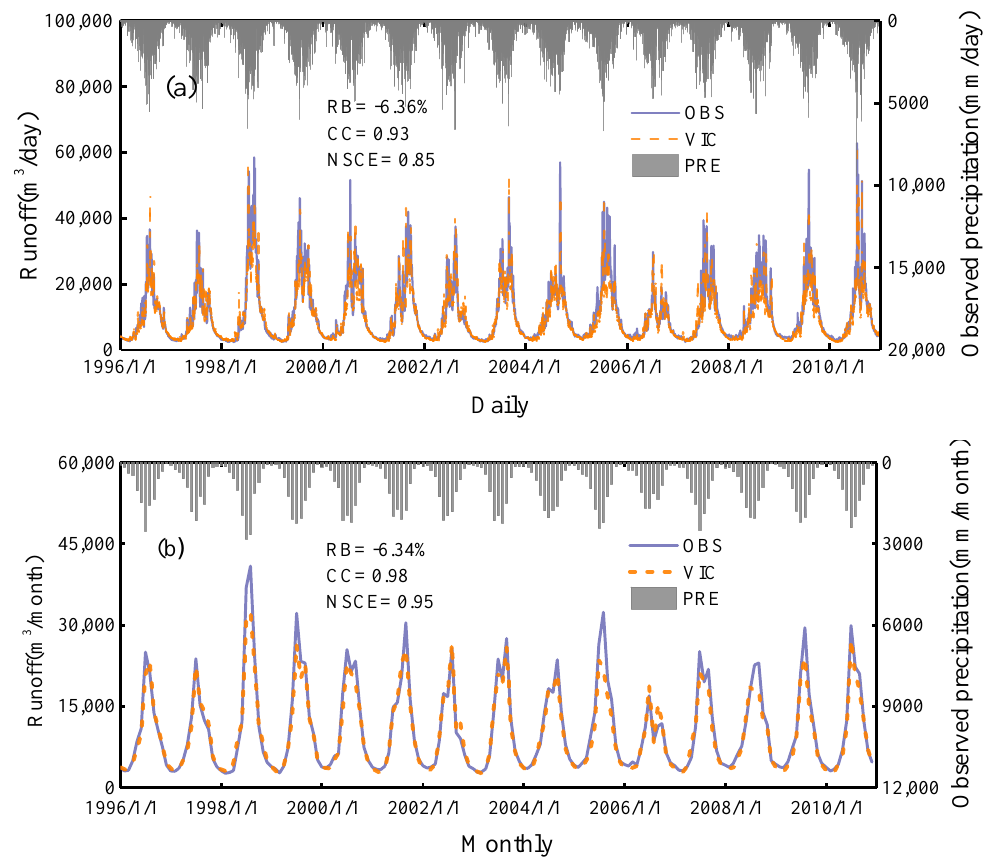
Figure 6. The runoff simulation in the upper Yangtze reaches using the VIC hydrological model: ( a ) Figure 6. The runo ff simulation in the upper Yangtze reaches using the VIC hydrological model: daily; ( b ) monthly. ( a ) daily; ( b ) monthly.